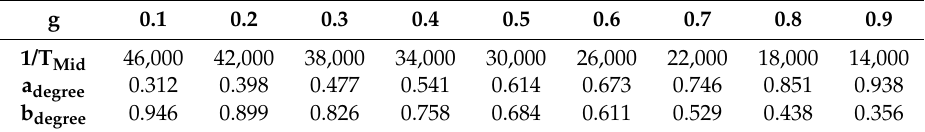
Table 2. Similarity of shape at the intermediate scale based on the beginning and end states of a polygon. g